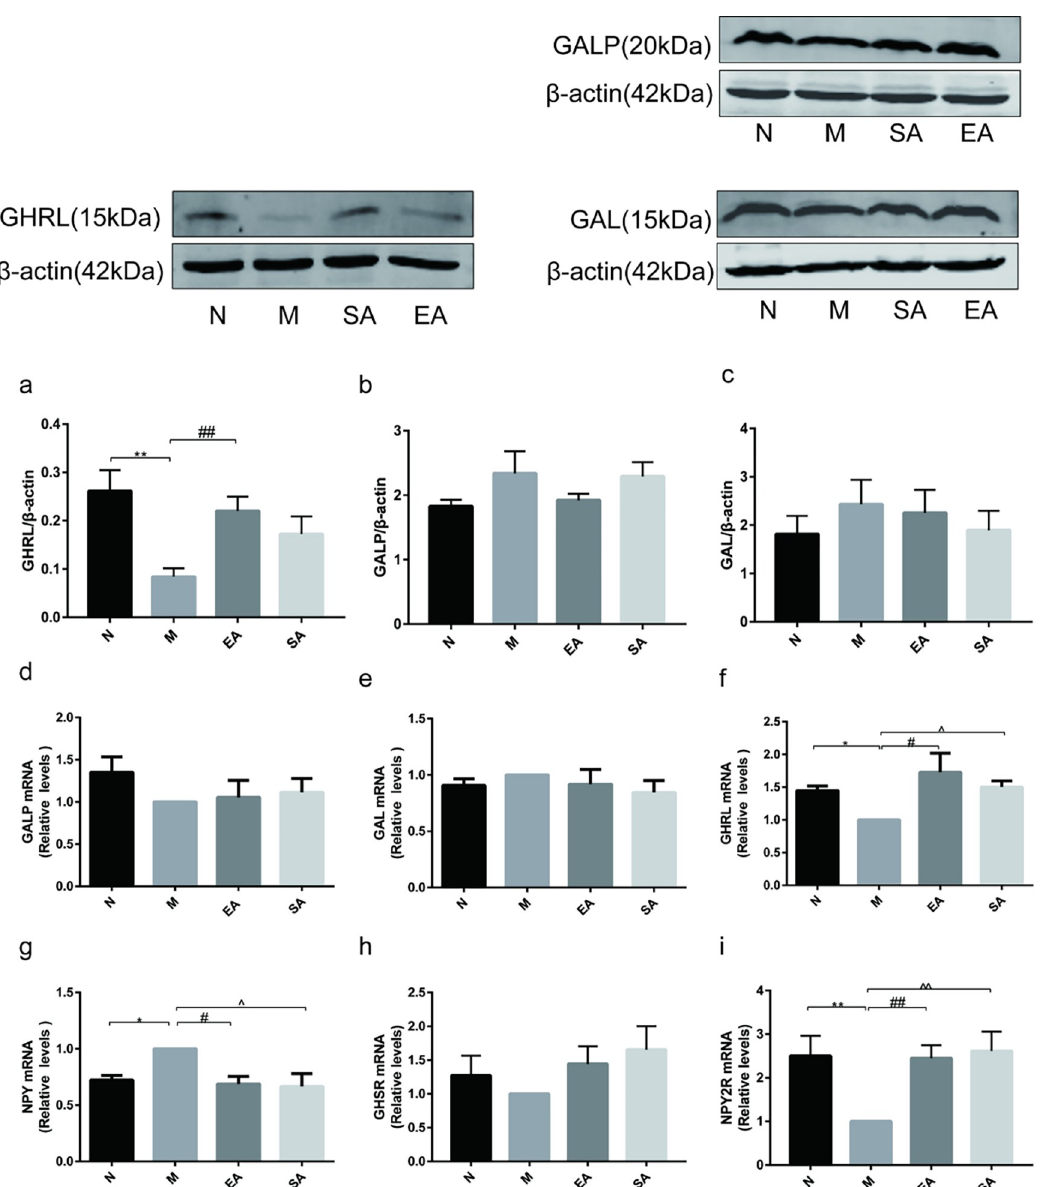
Fig 4. Expression of GAL, GALP, GHRL, NPY, NPY2R and GHSR in the hypothalamus. a-c: protein expression of GAL, GALP and GHRL in hypothalamus; d-i: mRNA expression of GAL, GALP, GHRL, NPY, GHSR and NPY2R in hypothalamus; N, normal group; M, model group; EA, electroacupuncture group; SA, sham acupuncture group; GAL, galanin; GALP, galanin-like peptide; NPY, neuropeptide Y; GHRL, ghrelin; GHSR, ghrelin receptor; NPY2R, neuropeptide Y2 receptor; The values are shown as mean ± SEM. N vs M, � P < 0.05, �� P < 0.01; EA vs M, # P < 0.05, # # P < 0.01; SA vs M, ^ P < 0.05, ^ ^ P <